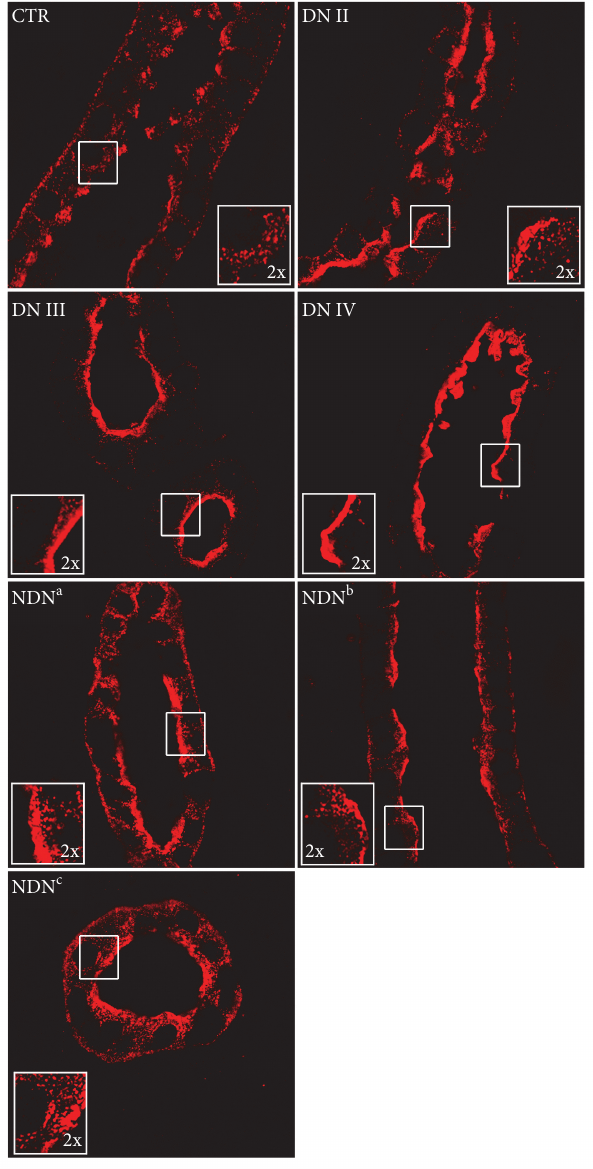
Figure 3: AQP2 plasma membrane localization increases in DN patients and with the clinical severity of DN. Human kidney biopsies from control kidney (CTR), DN, and NDN patients were subjected to immunofluorescence analysis of AQP2 subcellular localization. AQP2 immunostaining, shown in red, was visualized in the 𝑥𝑦 apical confocal plan. Confocal pictures are representative of AQP2 staining in the cortical collecting duct of normal kidney (CTR), kidneys of patients with class II (DN II), class III (DN III), and class IV (DN IV) DN, and kidneys of NDN patients. NDN a is a patient with membranous nephropathy and angiosclerosis, NDN b is a patient with chronic interstitial nephritis, and NDN c is a patient with endocapillary/extracapillary glomerulonephritis. Similar results were obtained in three patients per each